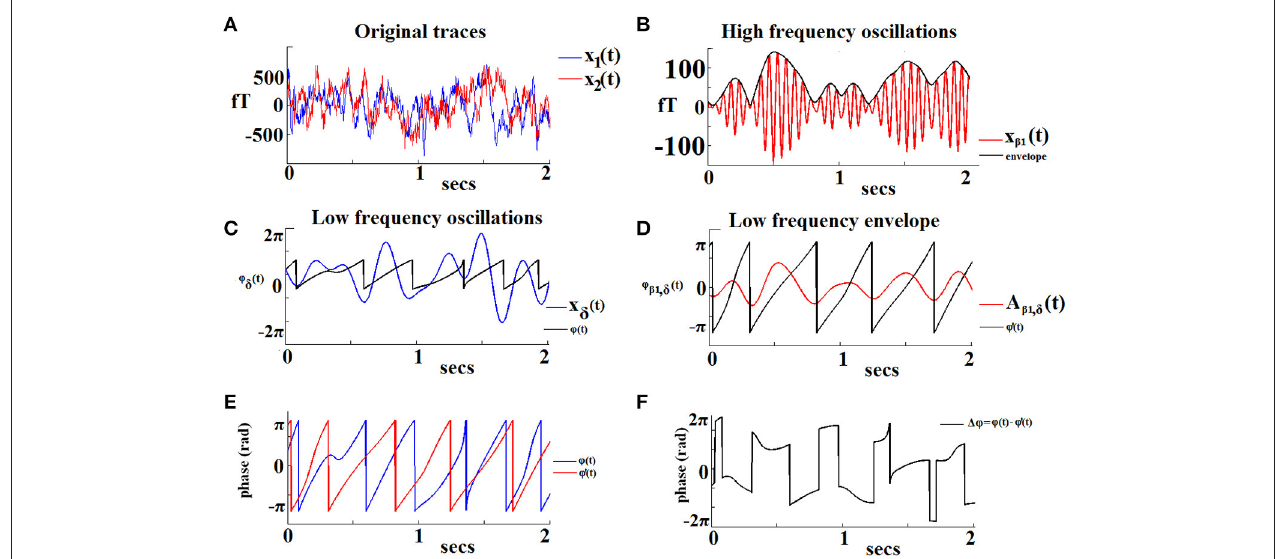
FIGURE 1 | An example of the algorithmic steps involved in the estimation of iPLV between the phase of δ oscillations recorded from a left frontal sensor (LF signal) and the amplitude of β 1 oscillations recorded from a right frontal sensor (HF signal). The two continuous MEG time series are shown in (A) . The HF signal filtered in the β 1 -band is shown in ( B ; red trace) with its amplitude modulation envelope superimposed (dark trace). Panel (C) displays the LF signal filtered in the δ -band (blue trace) along with its corresponding instantaneous phases ϕ ’ δ (t) (dark trace). The δ oscillations in the HF signal are shown in ( D ; red trace) with the corresponding instantaneous phases superimposed [ ϕ ’ δ (t)]. The evolution of instantaneous phases of the LF rhythm overlaid on the corresponding phases of the HF oscillation envelope is shown in (E) . The evolution of phase differences between the two signals ( 1 ϕ ) is used as an index of frequency-specific phase-amplitude coupling (PAC) between the two sensors (F)